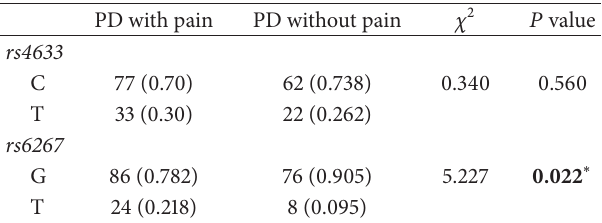
Table 2: COMT allele and PD with or without